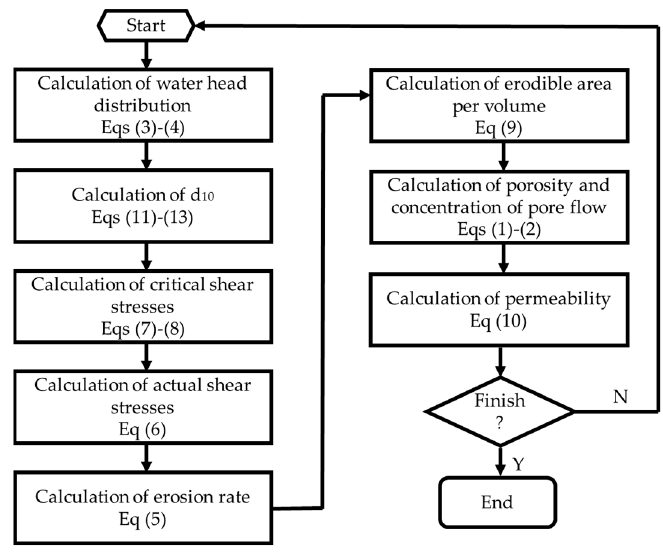
Figure 4. Flow chart of simulation program (Eq(s): Equation(s)).